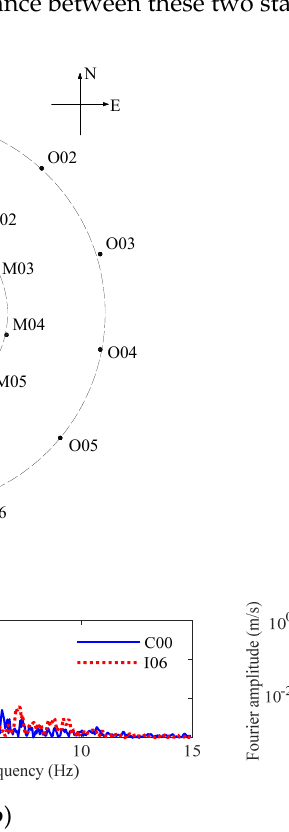
Figure 8. A simple seismic field. ( a ) ( c ) Figure 9. ( a ) Simulated accelerations. ( b ) Fourier spectra of the simulated accelerations. ( c ) Fourier spectra of the accelerations on a log–log scale. 3.2. Model Modification To solve the above-mentioned two problems, the amplitude and phase spectra were improved. 3.2.1. Modification of the Amplitude Spectrum Equation (23) is used to describe the change law of the Fourier amplitude spectrum: However, parameter α should change with frequency as follows: ( ) =F α ω α , (26) where F α is a function that needs to be determined. Herein, the accelerations in Figure 7 are taken as an example to study the function F α . The accelerations and their Fourier amplitude spectra are shown in Figure 7. For the con- venience of modeling, only records from 0 to 16 s were removed. Subsequently, based on Equation (25), parameter α can be obtained as follows: